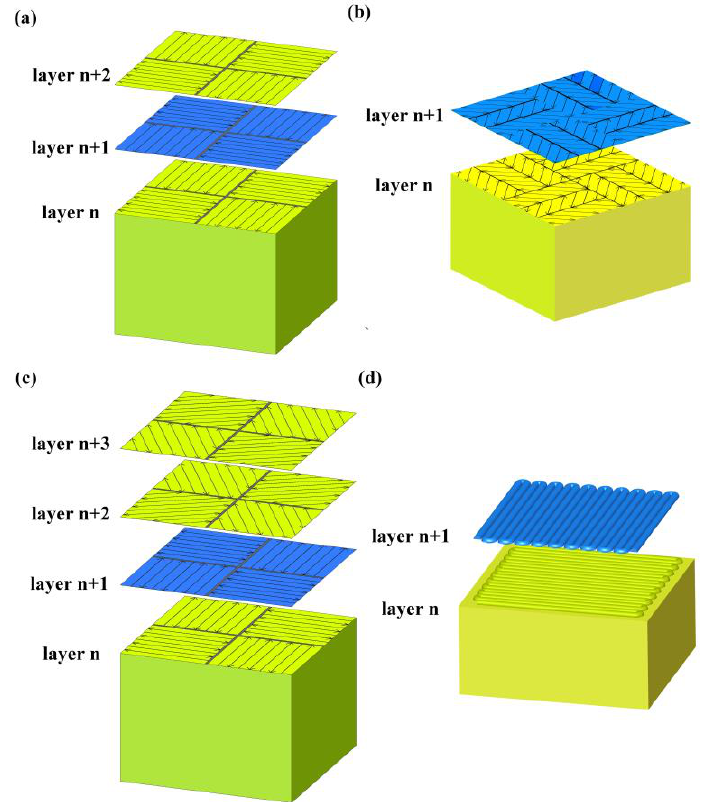
Figure 2. Schematic of three different divisional refilling strategy and “s” style orthogonal scanning strategy: ( a ) normal partition strategy; ( b ) oblique line and layer-staggered divisional strategy; ( c ) spiral divisional strategy; ( d ) “s” style orthogonal scanning strategy.